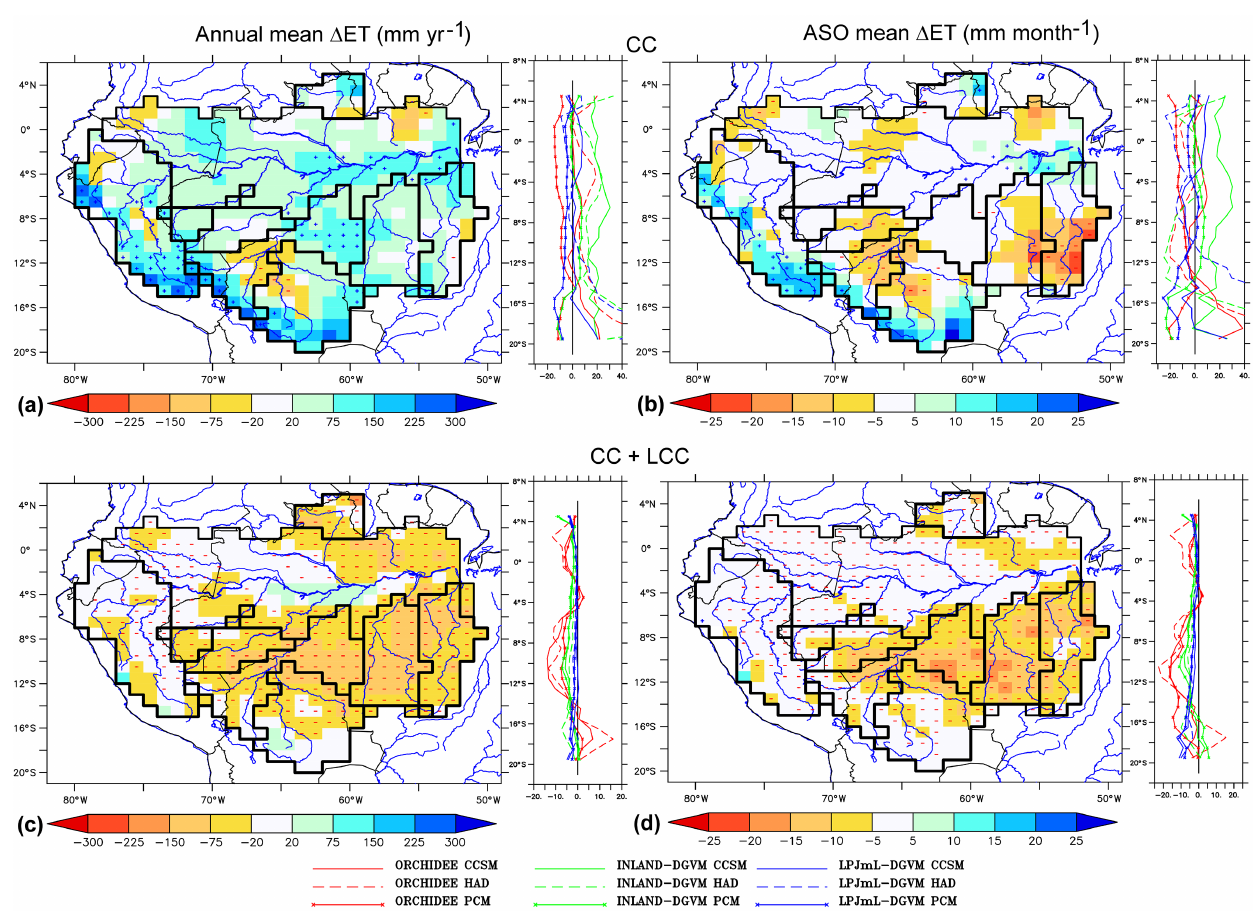
Figure 7. Maps indicate spatial change in (a, c) annual (mmyr − 1 ) and (b, d) ASO (mmmonth − 1 ) ET due to (a, b) climate change (mean of the three GCM forcings) and (c, d) deforestation combined with climate change (EXDEF) for the end of the century. The symbols indicate that more than six simulations out of nine (three GCM forcings × three LSMs) give an increase ( + ) or a decrease ( − ) of ET on the grid cell. The black lines delineate the Amazon Basin and the catchments. Plots indicate the corresponding zonal mean of relative changes in ET (%) from each of the nine